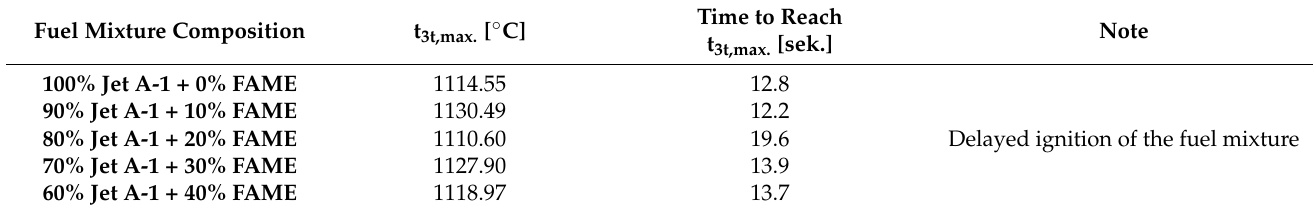
Table 15. Change in the maximum total gas temperature in front of the gas turbine t 3t, max. [°C] SJE- 20 with different concentrations of Jet A-1 aviation kerosene and FAME biofuel.